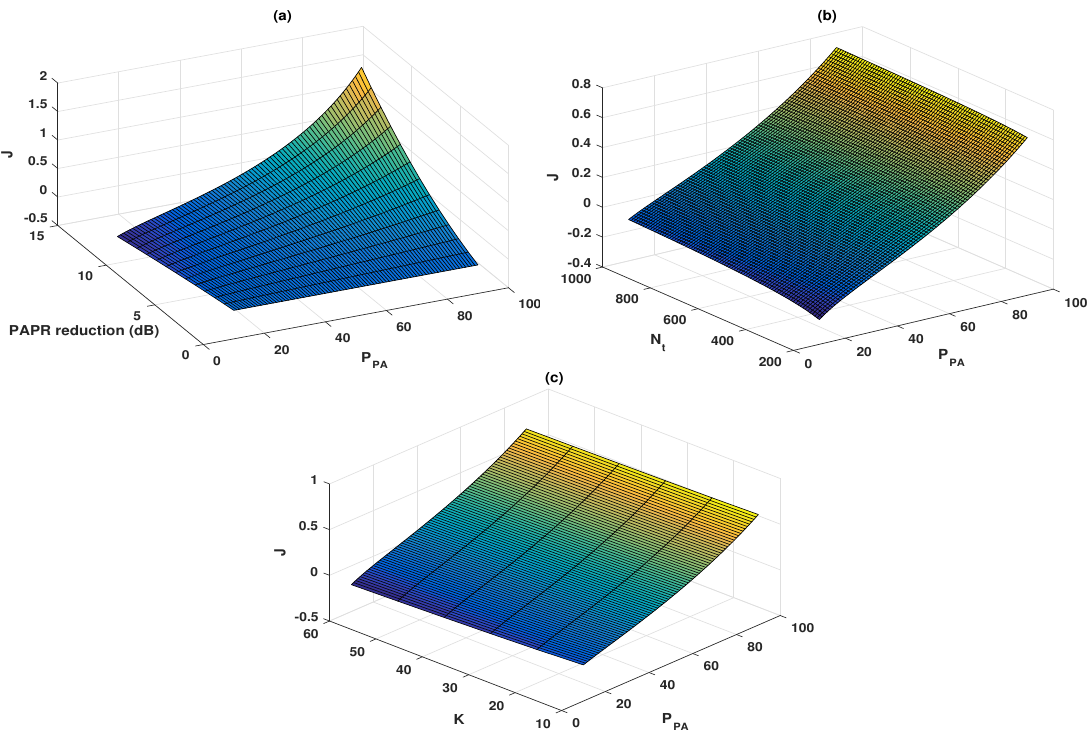
Figure 6. When N t = 400, K = 40, ( a ) J versus PAPR reduction (dB) and P PA ; ( b ) J versus N t and P PA ; ( c ) J versus K and P PA